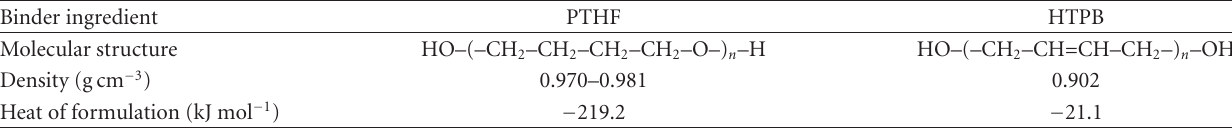
Table 1: Chemical properties of PTHF and HTPB.